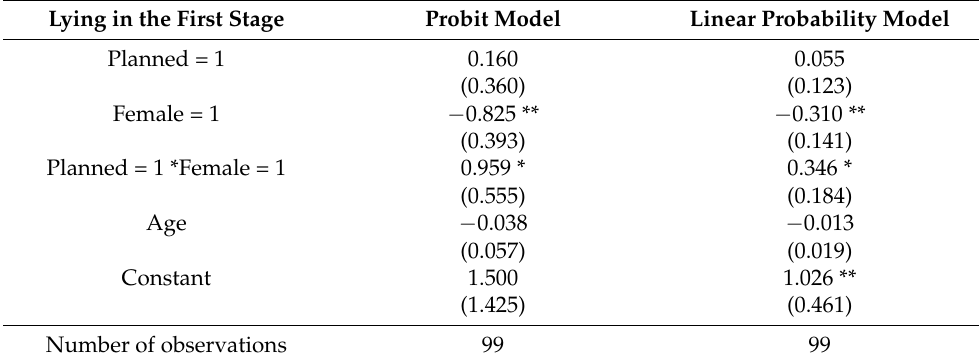
Table 3. Probit regression: Lying in the first stage.